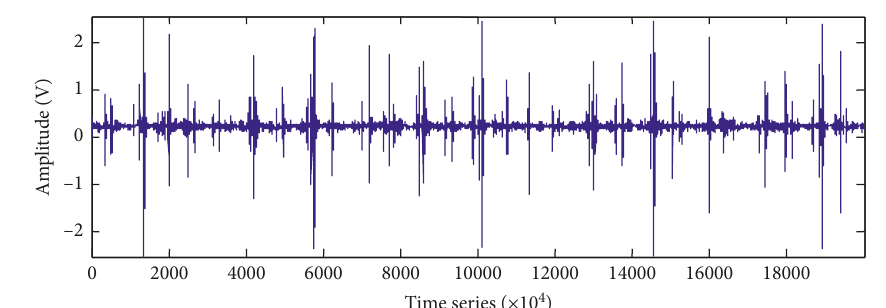
Figure 5: Vibration signal after wavelet denoising.